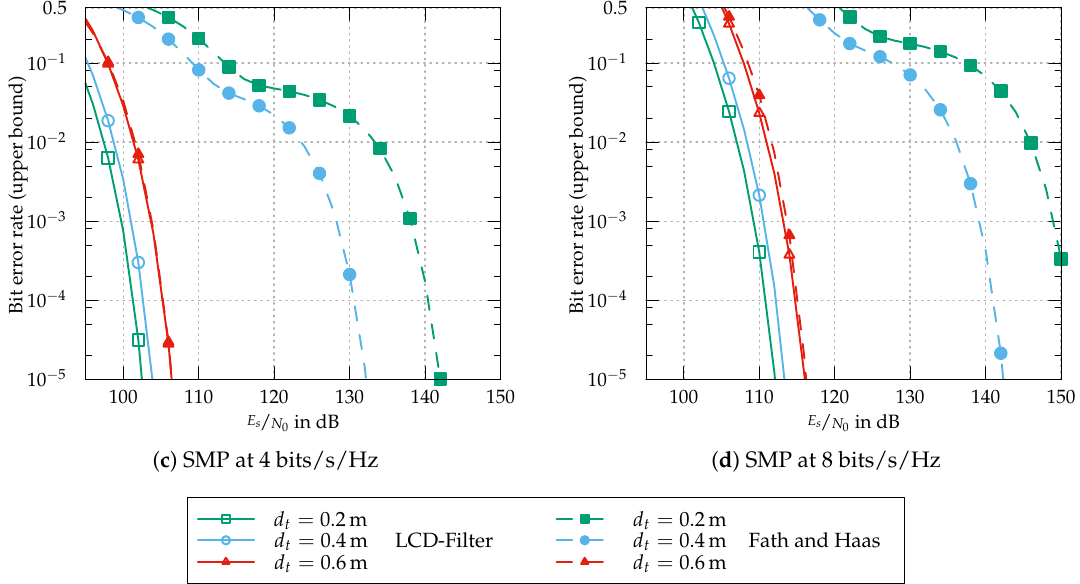
Figure 8. Comparison of LCD filter performance to conventional MIMO results presented in